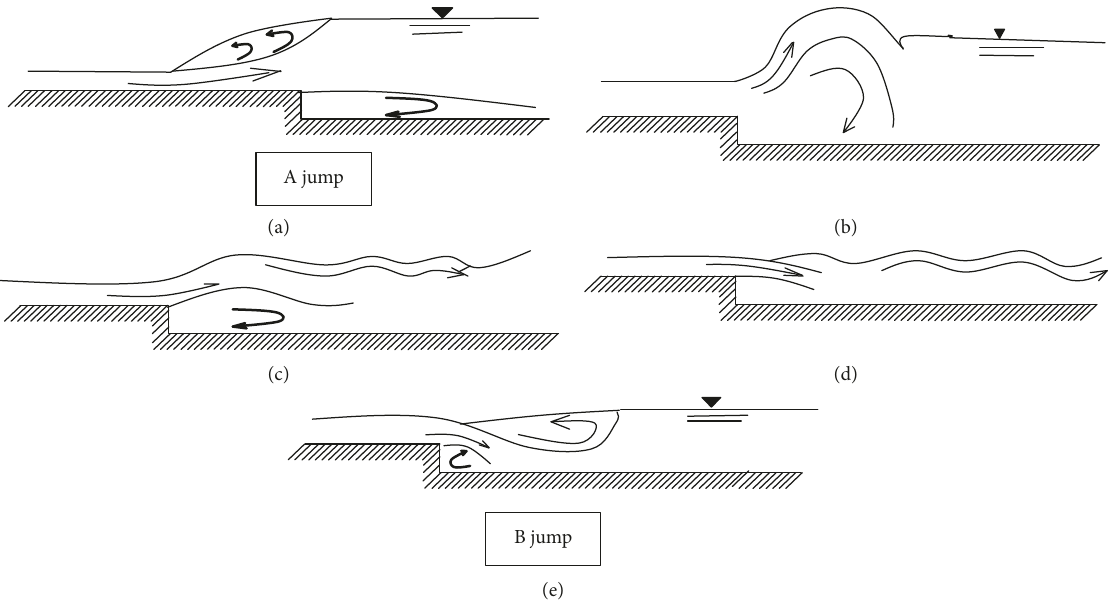
Figure 1: Flow conditions (from [3]): (a) A-jump, (b) wave jump, (c) wave train, (d) B-jump (maximum plunging condition), and (e) minimum B-jump (limited